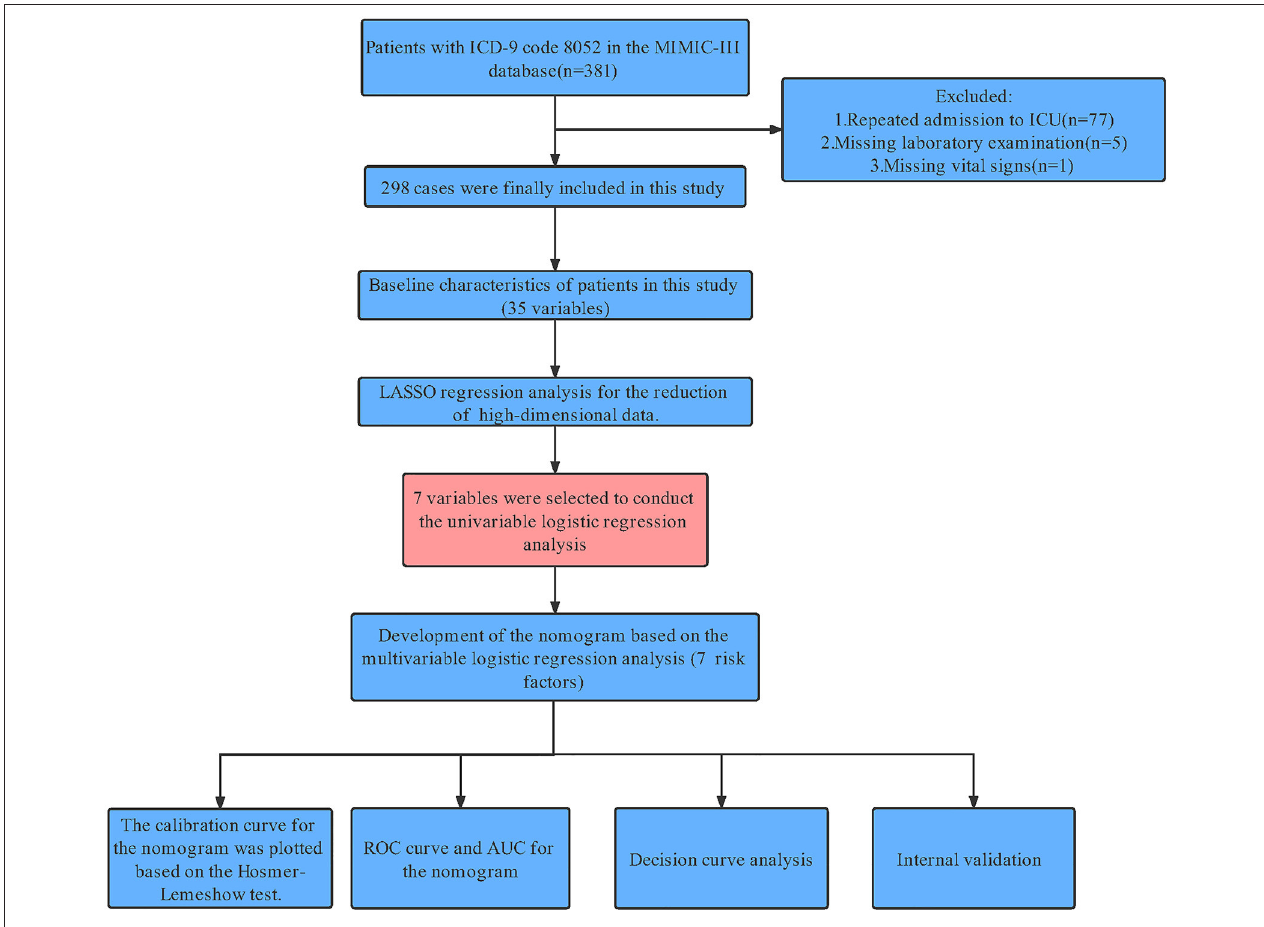
FIGURE 1 | Workflow of the study. MIMIC-III, Medical Information Mart for Intensive Care III; ICU, intensive care unit; LASSO, least absolute shrinkage and selection operator; AUC, area under the curve; HL test, Hosmer-Lemeshow goodness-of-fit test; DCA, decision curve analysis.